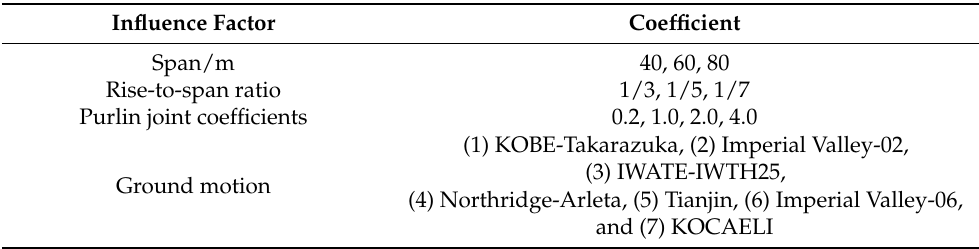
Table 1. Different parameters of spherical reticulated shells with roofing systems.